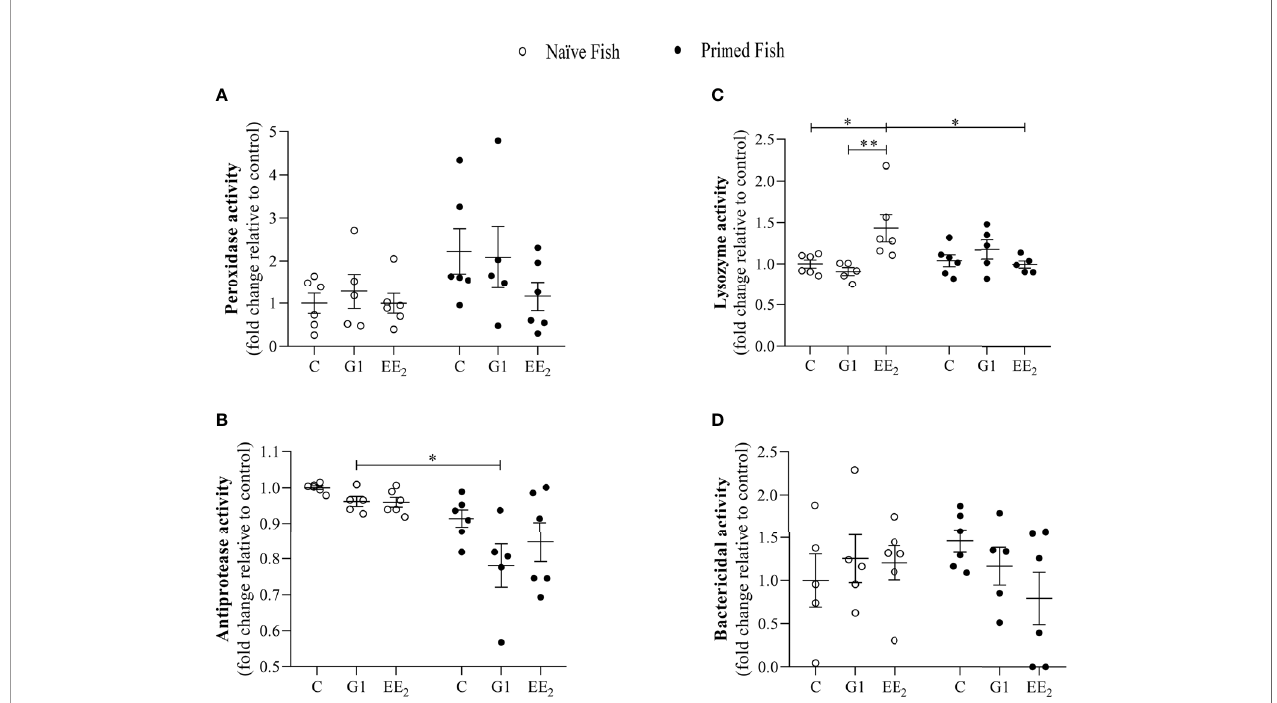
FIGURE 4 | The gut mucus antimicrobial humoral activity is seldom affected by the presence of 17 a -ethinylestradiol (EE2) or KLH-immune priming in gilthead seabream. The fi sh had been orally treated with G1 or EE2 (5 m g/g food) for 43 days and either immune primed with KLH or not (naive) on the previous day. (A) Peroxidase, (B) Lysozyme, (C) Antiprotease (D) Bactericidal activity. Data represent means ± standard error (n=6). Asterisks denote statistically signi fi cant differences between the groups. *(p<0.05)